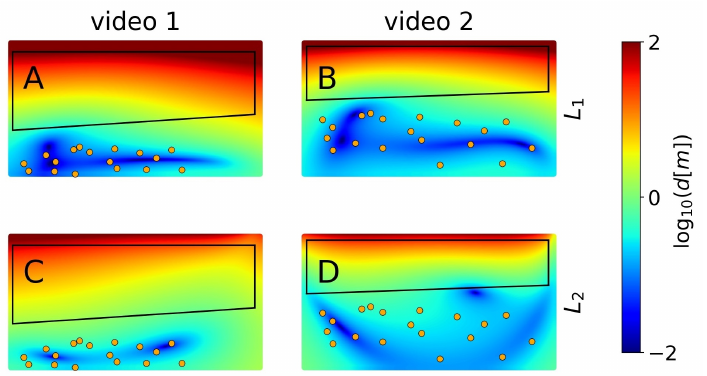
Figure 14. Decimal logarithm of the xy -distances, d (in meters), of the projected pixels using F and L i for video 1 ( A , C ) and video 2 ( B , D ). The plots also include the pixel-domains for each video (black boxes) and the GCPs (orange